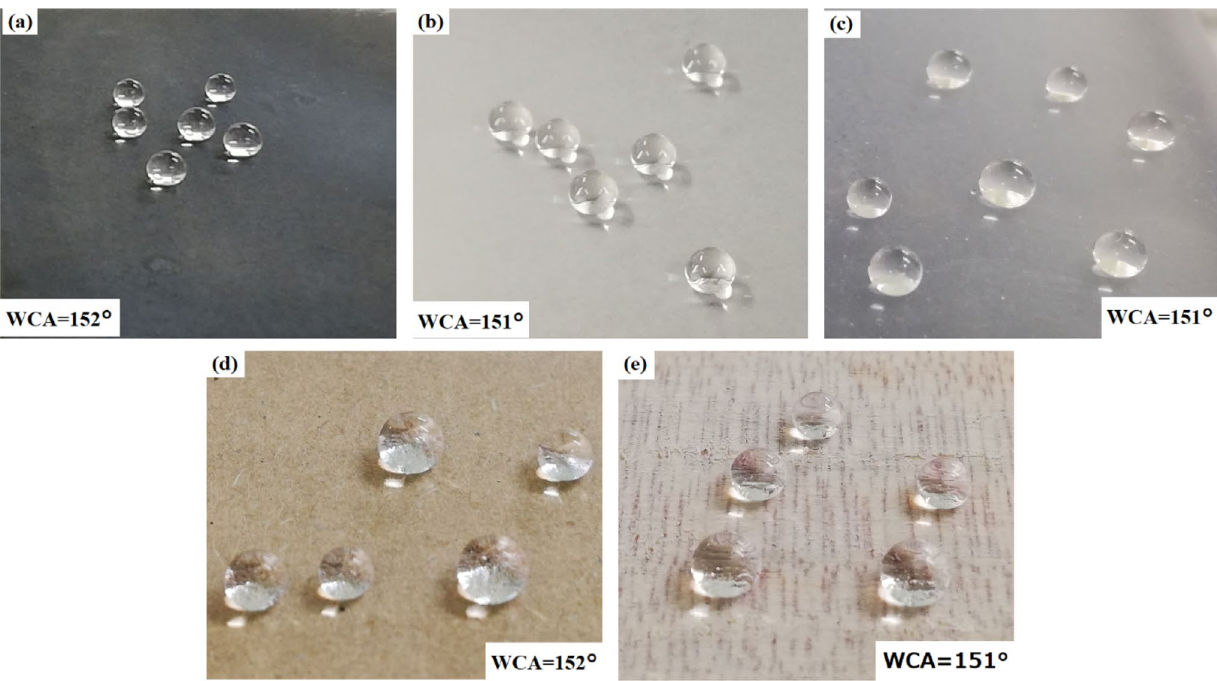
Fig. 8 Optical photographs of water droplets on the coating sur- face deposited on various substrates by one-step spray coating of the coating solution obtained from the composition No. 5 by